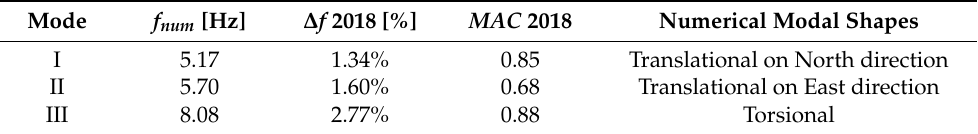
Figure 7. Numerical model discretization at the final step ( a ) and the corresponding first three modal shapes ( b ). Table 4. Comparison of the modal frequencies and shapes between the final FEM and the OMA results.